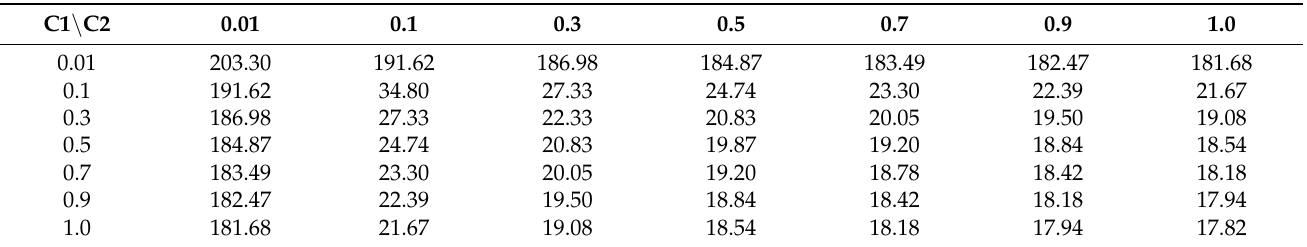
Table 6. R M- model ( Ω cm 2 ) of the relationship between the calculated resistance and the concentration of the external salt solution.